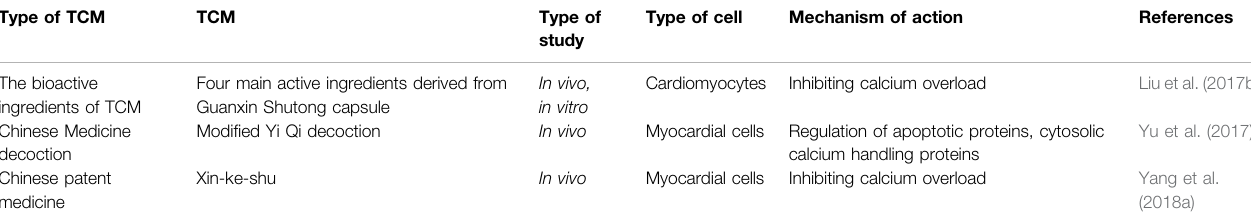
TABLE 5 | The mechanism of TCM in the treatment of coronary heart disease and myocardial infarction through calcium